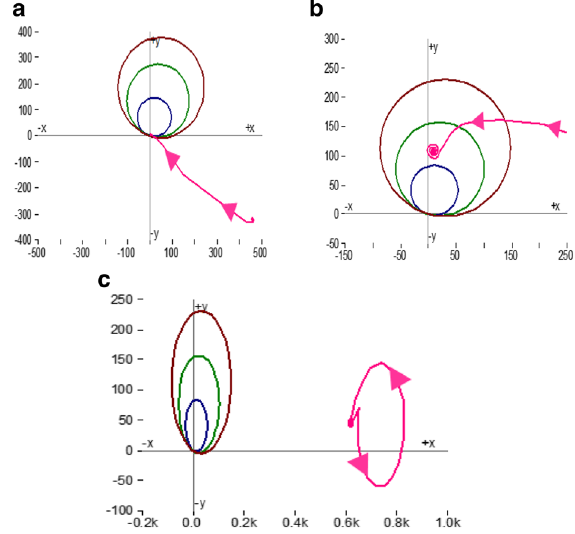
Fig. 5 Performance of ( a ) R 12 , ( b ) R 21 & ( c ) R 23 for LL (RY) fault at 550 km from Bus-1 (i.e. 200 km from